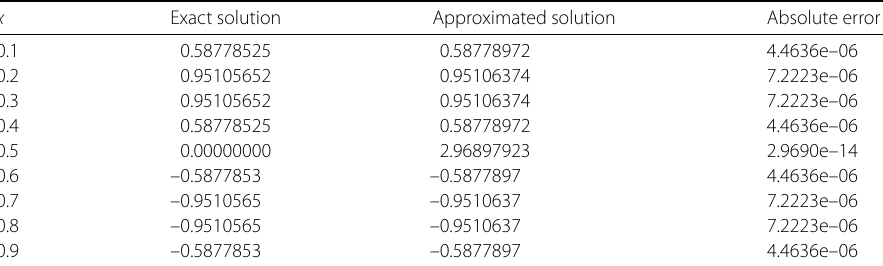
Table 6 A comparison of exact values and approximated values at different knots x Exact solution Approximated solution Absolute error